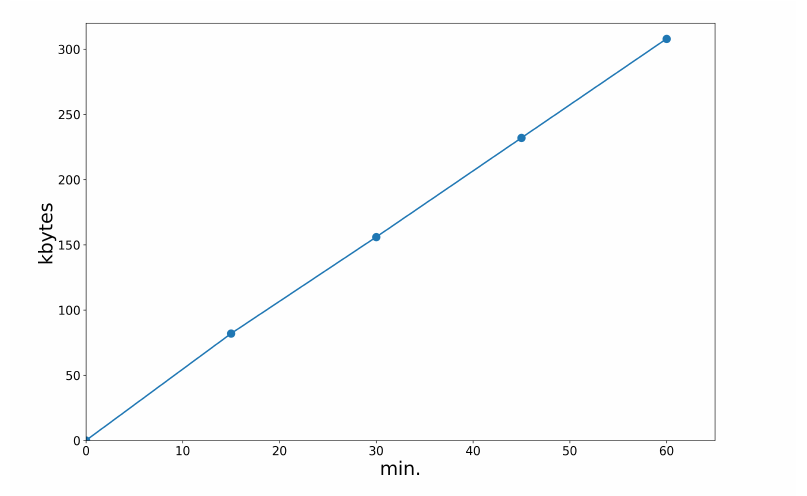
Figure 13. SafeCyclists data consumption over